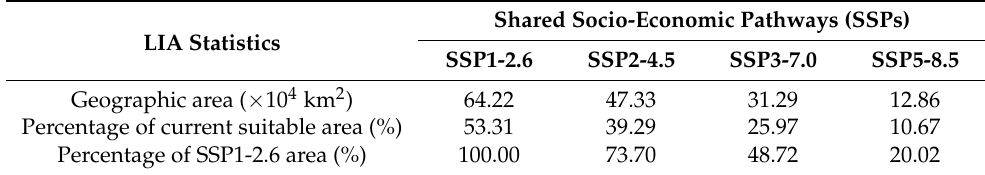
Figure 6. Composite prediction of low impact areas supported by varying numbers of shared socio-economic pathways (SSP1-2.6, SSP2-4.5, SSP3-7.0 and SSP5-8.5). Table 3. Low impact areas (LIAs) under different shared socio-economic pathways